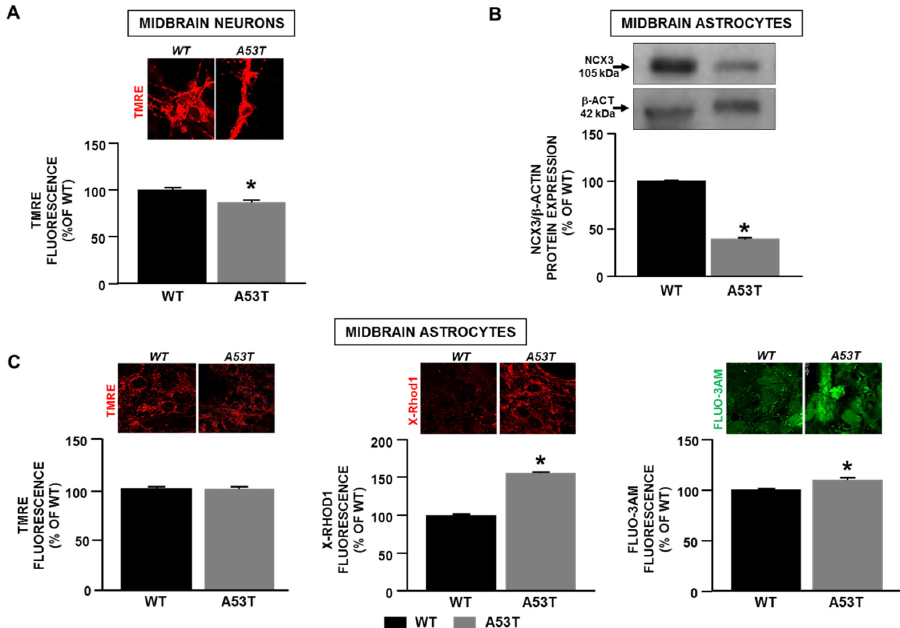
Figure 1. Mitochondrial function and NCX3 expression in mesencephalic neuronal cells from A53T- α -syn and WT mouse embryos/pups. ( A ) Quantification of the changes in mitochondrial membrane potential measured in primary mesencephalic neurons from A53T- α -syn and WT mouse embryos by confocal microscopy. ( B ) Quantification of NCX3 expression in primary mesencephalic astro- cytes from A53T- α -syn and WT mouse pups (P1). ( C ) Quantification of mitochondrial membrane potential, [Ca 2+ ] m and [Ca 2+ ] c in primary astrocytes from A53T- α -syn and WT mouse pups by confo- cal microscopy (P1). In A and C: each bar represents the mean ± S.E.M. of the percentage of fluores- cence intensity values of at least 20–30 neurons recorded in three independent experimental ses- sions. In B: each bar represents the mean ± S.E.M of the percentage of the NCX3 protein expression obtained in three independent experimental sessions. * p < 0.05 vs. WT neurons/astrocytes. 2.2. Differences in Ncx3 Expression in Nigrostriatal Pathway Are Associated with Mitochondrial Impairment in A53t- α -Syn Transgenic Mice During Aging. Further experiments were performed ex vivo in midbrain and striatum obtained from 4 and 16-month-old A53T- α -syn and WT mice to demonstrate the mechanistic link between NCX3 protein expression and mitochondrial dysfunction as a potential pathoge- netic mechanism leading to PD progression. As reported in Figure 2, a decrease in the expression of NCX3 was detected in the midbrain of 4-month-old A53T- α -syn (Figure 2B), whereas an increase in the expression of NCX1 was detectable in the striatum during mice aging (Figure 2C). To confirm that the impairment in NCX3 protein expression was re- sponsible for mitochondrial dysfunction, the expression of cytochrome c (cyt c), a marker of mitochondrial damage, and of neuronal nitric oxide synthases (nNOS), a marker of mi- tochondrial oxidative stress, was measured in 4 and 16-month-old A53T- α -syn and WT mice (Figure 3). The results of these experiments revealed an increase in cyt c expression in the midbrain of A53T- α -syn mice which occurred already in the early stage of disease (4-month-old mice) (Figure 3A), while in the striatum of A53T- α -syn mice, the increase in cyt c was detectable only in 16-month-old mice (Figure 3C). Interestingly, in the midbrain of A53T- α -syn mice the increase in cyt c expression was accompanied by an increase in nNOS expression level (Figure 3B), whereas in the striatum of A53T- α -syn mice, an in- crease in nNOS protein expression occurred only in 16-month-old A53T- α -syn mice (Fig- ure 3D). These results are in line with those obtained in vitro, suggesting a possible rela- tionship between the level of NCX3 expression and mitochondrial dysfunction.